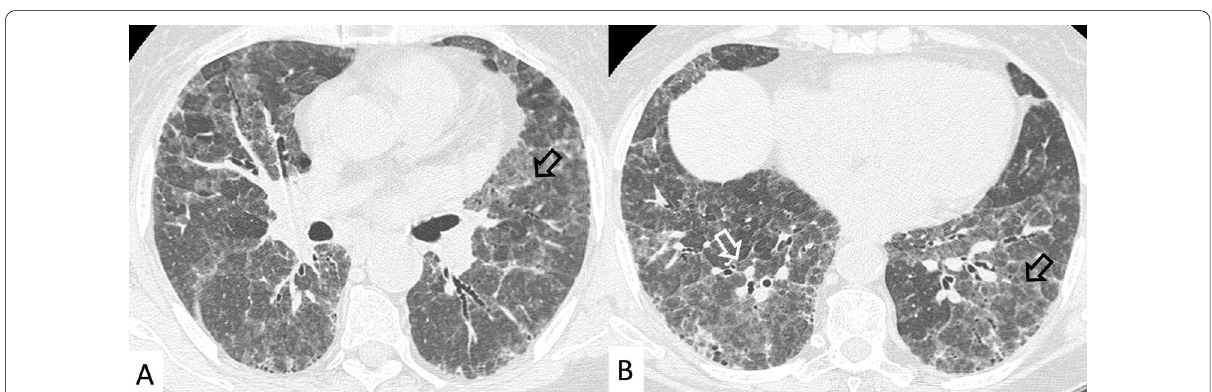
Fig. 29 A NSIP pattern in a female patient with diagnosis of MCTD. HRCT show ground-glass areas (white and black empty arrows) in figures A and B . Reticulations and small cystic areas are also evident, in this fibrosing